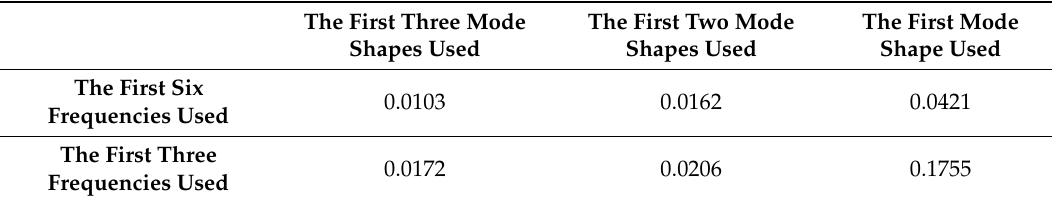
Table 9. Maximum difference between the identified damage factor and the theoretical value in the traditional method using different